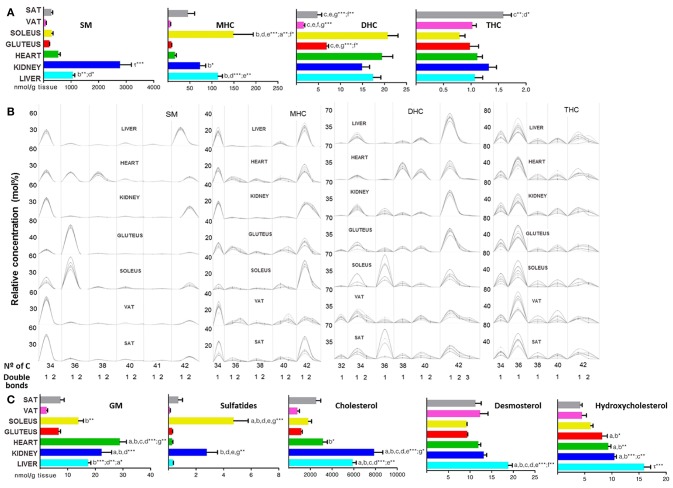
Structural sphingolipids and sterol lipids within mammalian tissues detected by targeted lipidomic analysis. (A,C) Concentration of SP and ST subclasses. Values are expressed as mean ± SEM from 8 to 10 animals. Statistical analysis was one-way anova and post-hoc Tukey significance is represented in the bar chart, meaning a significantly different respect to SAT, b respect to VAT, c respect to soleus, d respect to gluteus, e respect to heart and f respect to kidney, g respect to liver, τ respect to all. *p < 0.05, **p < 0.01, and ***p < 0.001. (B) Relative concentration of lipids normalized per sample to the total abundance within this lipid class to obtain molar fractions. Each solid line indicated tissue from an individual rat. Gray vertical lines separate lipids by total number of acyl chain carbons. The number of double bonds is indicated below within each group.